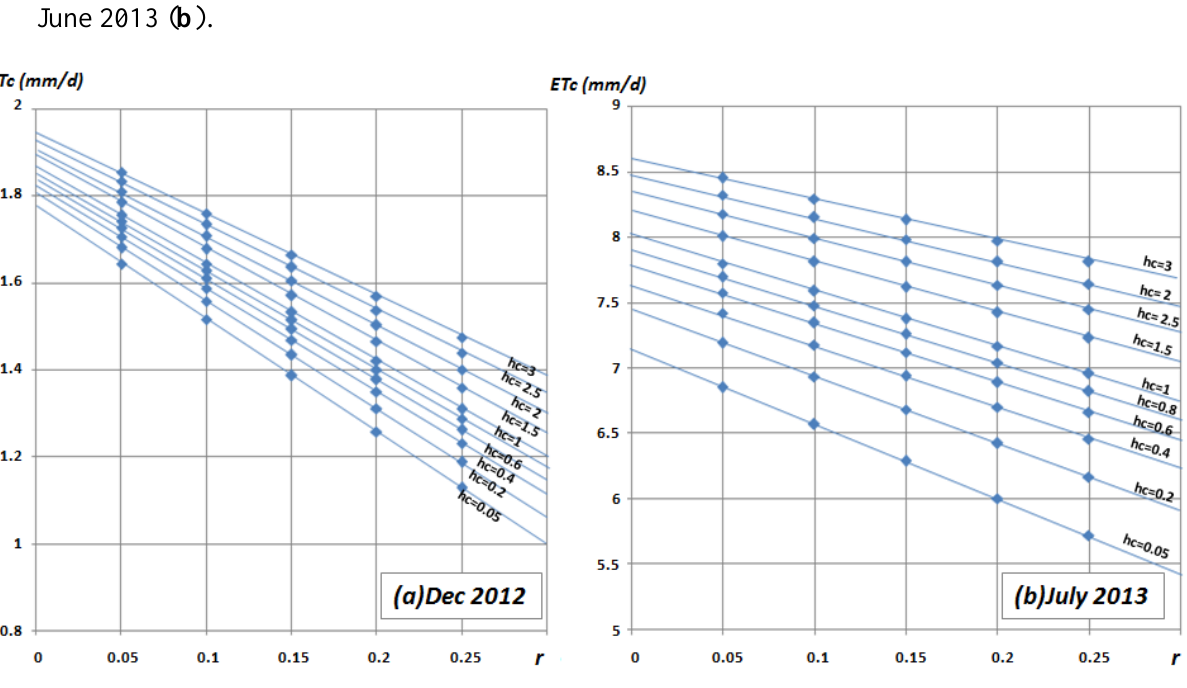
(analytical method) and the c and LAI = 2, in December 2012 ( a ) and c